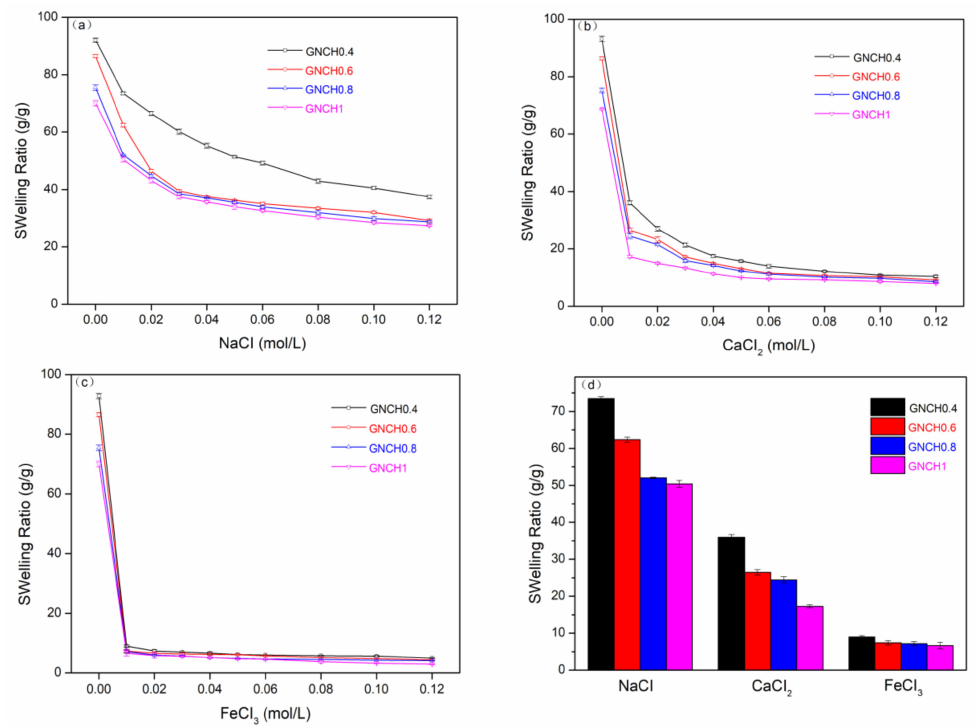
Figure 8. Swelling variation of GNCH in ( a ) NaCl solution, ( b ) CaCl 2 solution, ( c ) FeCl 3 solution, ( d ) Swelling ratio of hydrogels in di ff erent salt solutions (0.01 M): NaCl, CaCl 2 , and FeCl 3